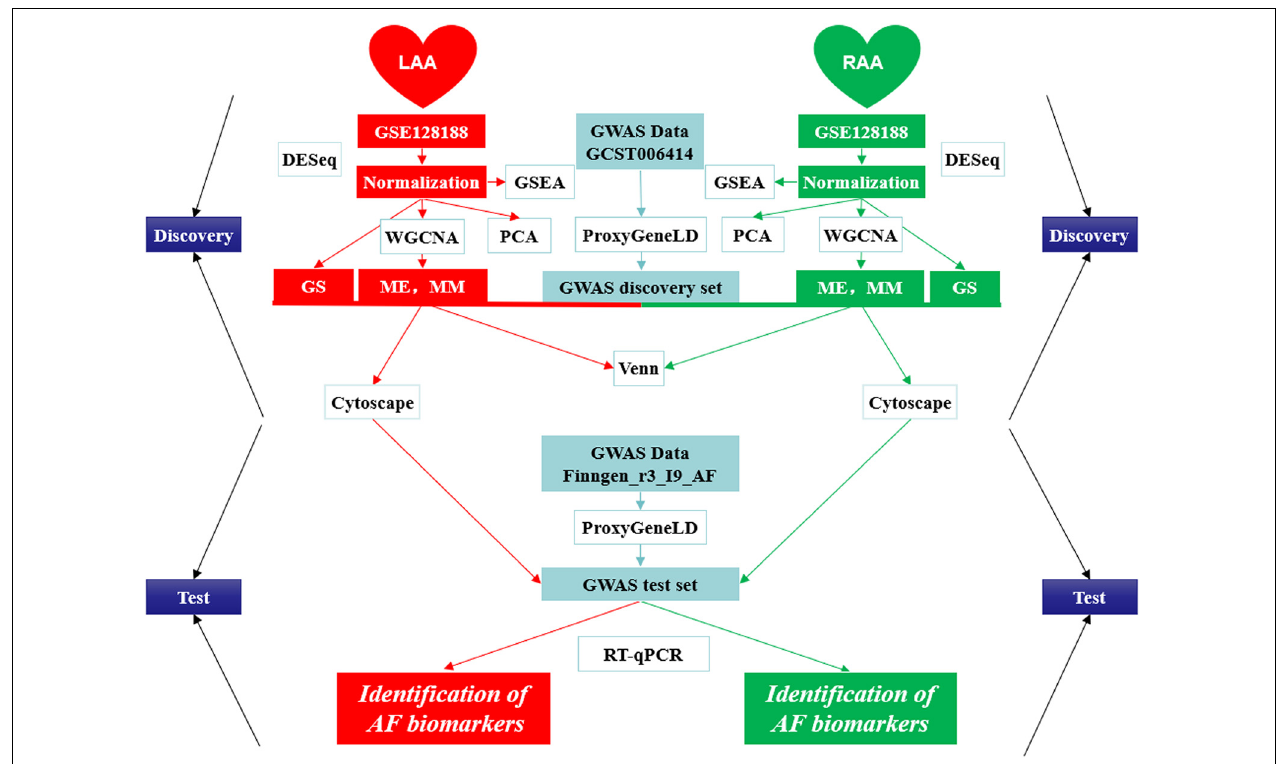
FIGURE 9 | The design scheme of this study. GS, gene significance; LAA, left atrial appendage; ME, module eigengene; MM, module membership; PCA, principal component analysis; RAA, right atrial